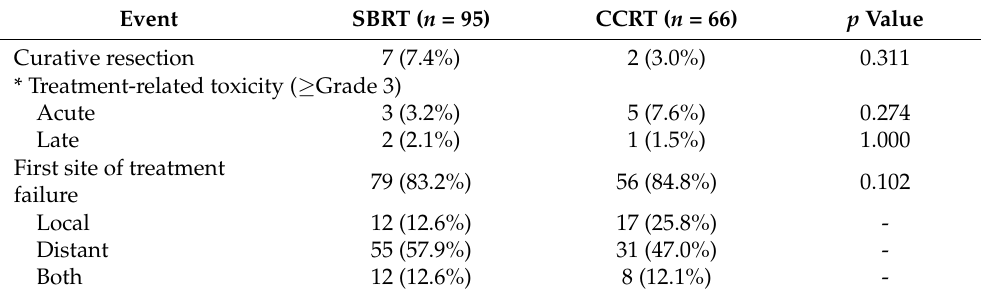
Figure 2. Recurrence and survival outcomes in the propensity score-matched cohort. ( A ) overall survival (OS), ( B ) progression-free survival (PFS), ( C ) freedom from local progression (FFLP). Table 5. Events after